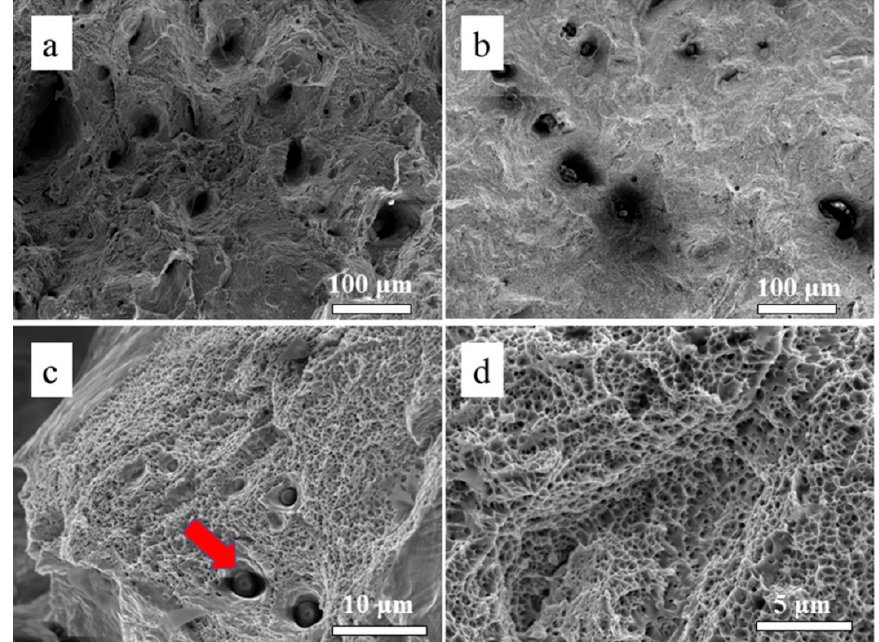
Figure 10. Fracture morphology of SLM-processed 316L tensile samples: ( a ) laser power of 200 W; ( b ) laser power of 170 W; ( c ) magnification of fracture surfaces with laser power of 170 W and ( d ) ductile dimple fracture with laser power of 170 W.